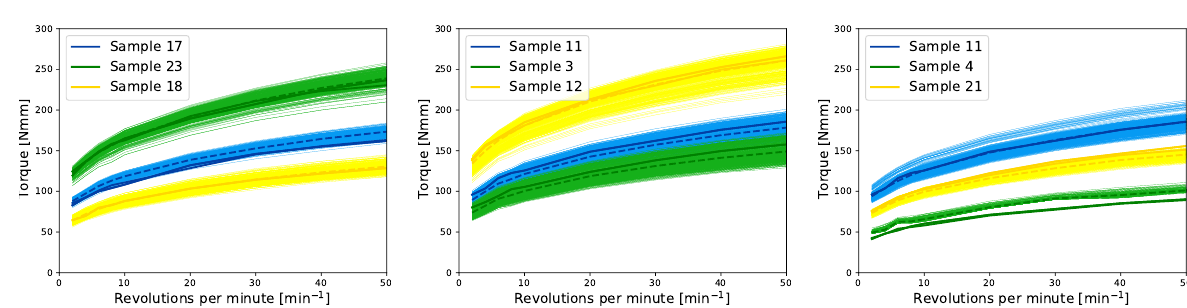
Figure 7. Results for the test sets of 3 different training splits. All predictions of the images belonging to a sample are shown with a thin line in the colour of the respective sample. The thicker dashed lines in the darker colours mark the average prediction values over all test images of a sample. The thicker solid lines in the same colour indicate the reference value (in case two measurements were available, both are